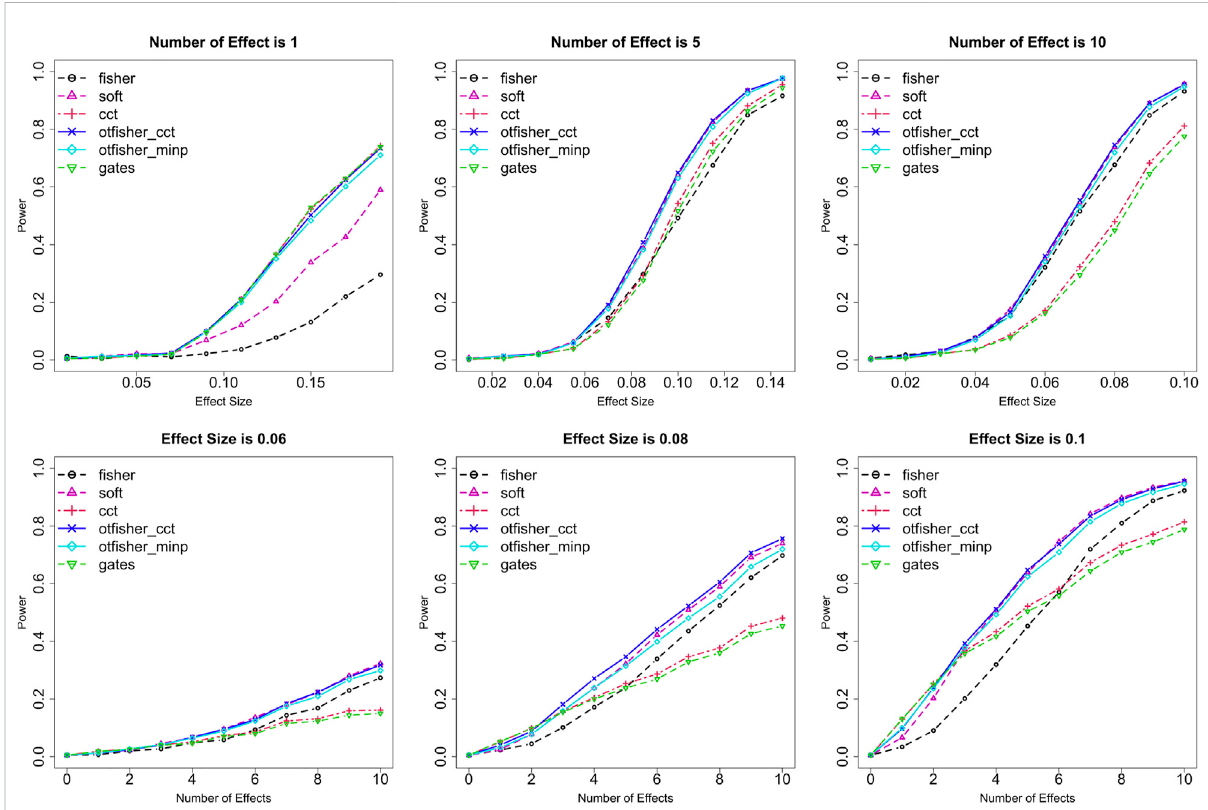
FIGURE 1 Statistical power for binary traits from common SNPs. Row 1: Fixing the number of causal SNPs m = 1, 5, and 10, and varying effect size β on x - axis.Row2:Fixing β =0.06,0.08, and 0.1,andvarying m on x -axis. Testingmethods: fi sher:Fisher ’ smethod; soft: soft-thresholdingTFisherwith τ 1 = τ fi sher_minp: oTFisher in Eq. 2; ot fi sher_cct: oTFisher in Eq. 3; gates: extended Simes 2 = 0.05; cct: Cauchy combination test; ot